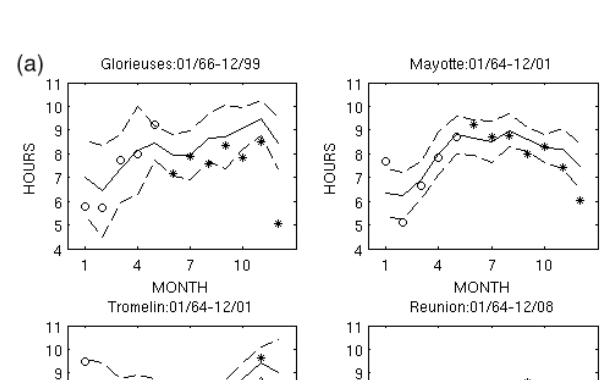
that, during the QBO’s westerly phase, low-altitude (less than 22 km) aerosols and trace gases spread poleward, whereas during the QBO’s easterly phase, lower-stratospheric